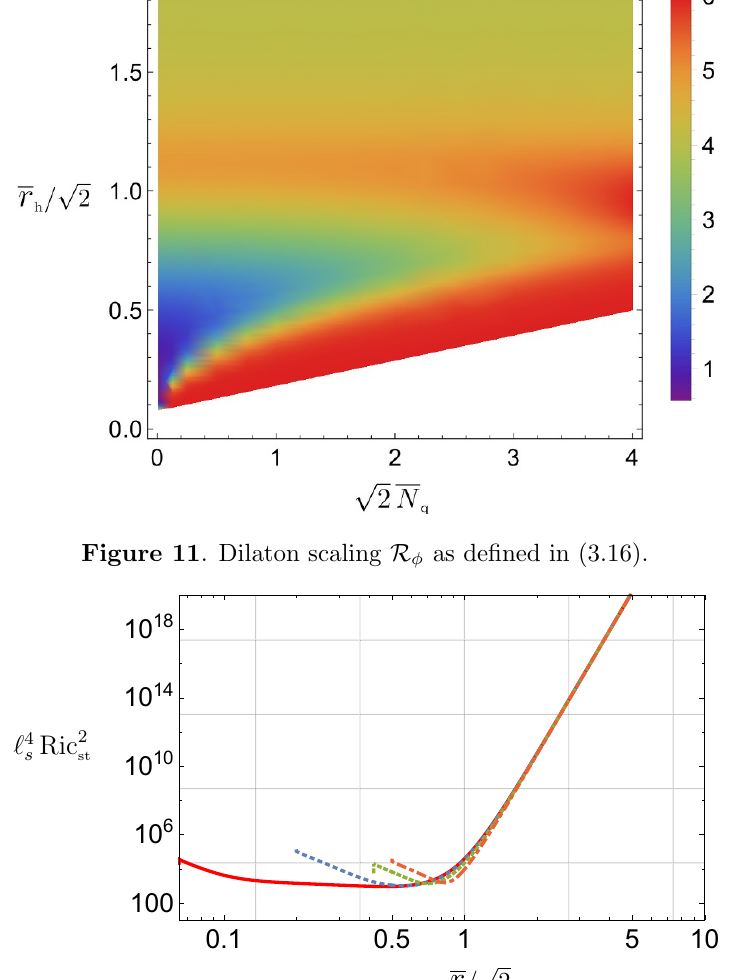
Figure 12 . Square of the Ricci tensor, Ric 2 = R mn R with different charge densities (see legend in figure